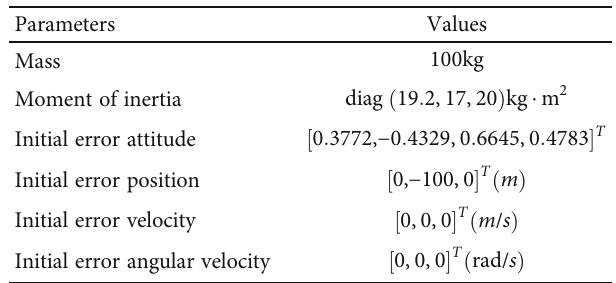
Table 2: Initial values in simulation.